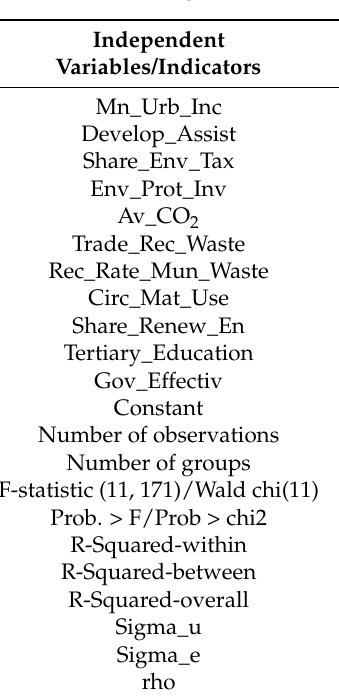
Table 7. Statistical significance of the considered